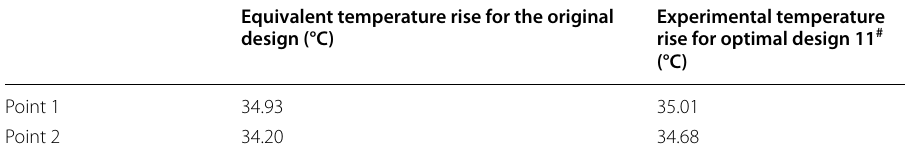
Table 7 The temperature rises at the measurement point 1 and 2 at an ambient temperature